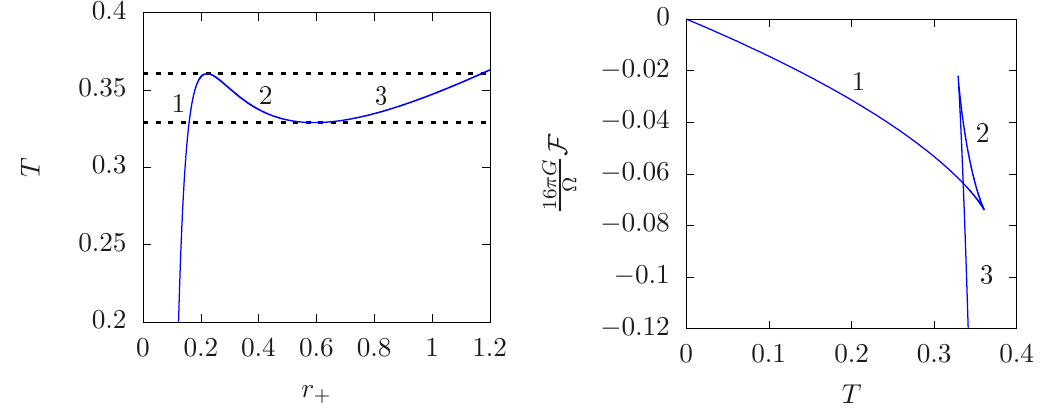
Figure 2 . Plots of T vs. r + (left) and vs. T (right) for q = p 0 : 3 q crit in the case n = 0 : 4, (cid:23) = 0 : 3, F L 2 = ‘ 2 = 2, and D = 4. In this case, the critical charge has the value q crit = 0 :